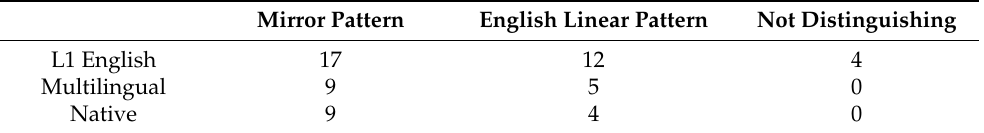
Table 7. Individual speakers classified as to their preferred word order pattern with respect to multiple adjectives (mirror image, English linear, or not